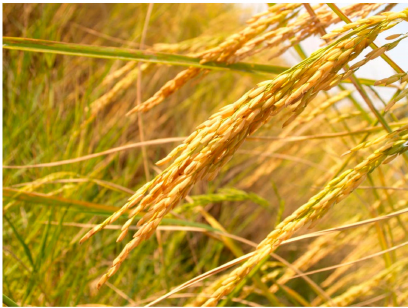
Figure 4. Oryza sativa . (From: https: // www.pexels.com / photo / close-up-photo-of-rice-grains-during- daytime-162992 / ).